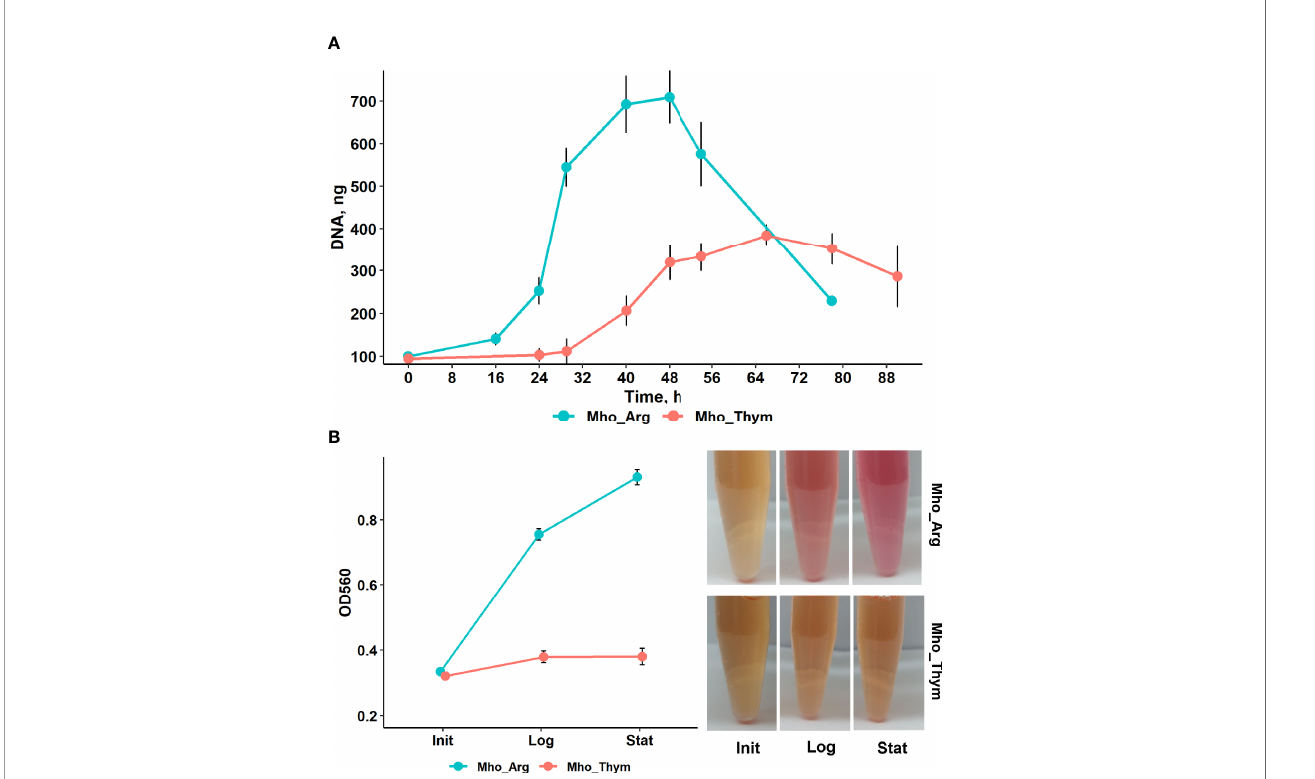
FIGURE 1 | The growth curves of M. hominis on medium supplemented with arginine or thymidine. (A) Growth curves of M. hominis . All points are averages of triplicate experiments with standard deviation error bars (B) M. hominis was cultured in BHI media containing phenol red with arginine or thymidine. Arginine utilization and as a consequence production of ammonia was indicated by the color change of indicator to pink. The OD560 values were measured in three time point – after dilution of the third passage culture of M. hominis H34 in appropriate medium (Init), 0 h for both culture; in the mild-log phase (Log), 30 h for arginine supplemented culture, 42 h for thymidine; and in the stationary phase (Stat), 45 h and 65 h,